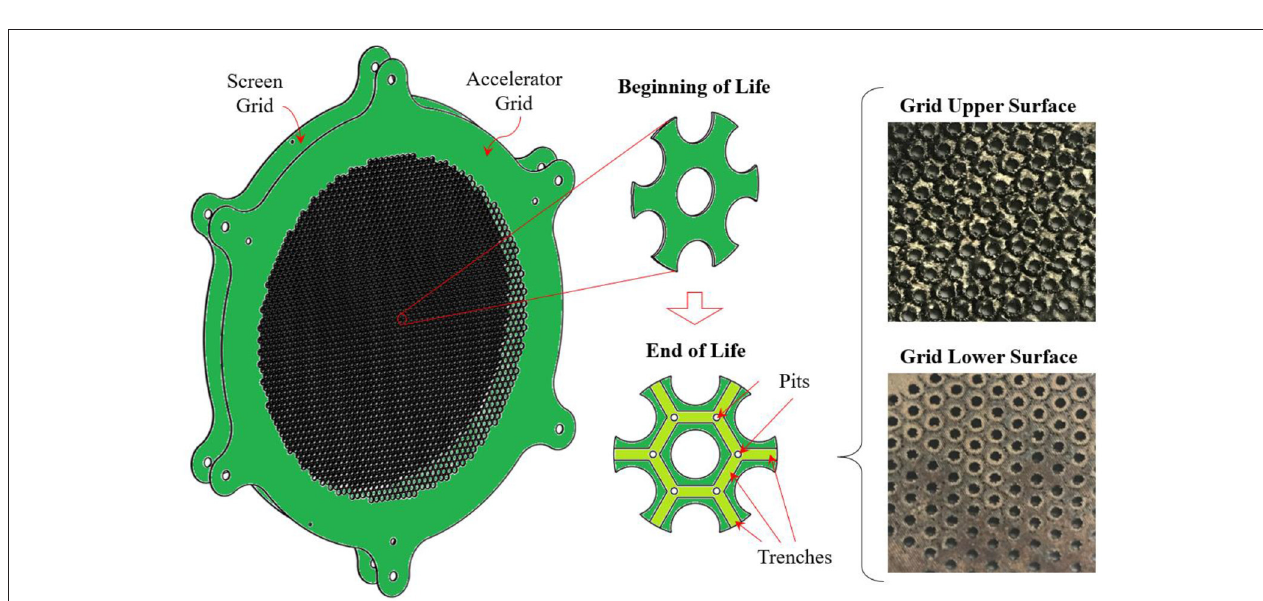
FIGURE 15 | Ion optics erosion pattern and the pattern exhibited by the unsuccessfully formed